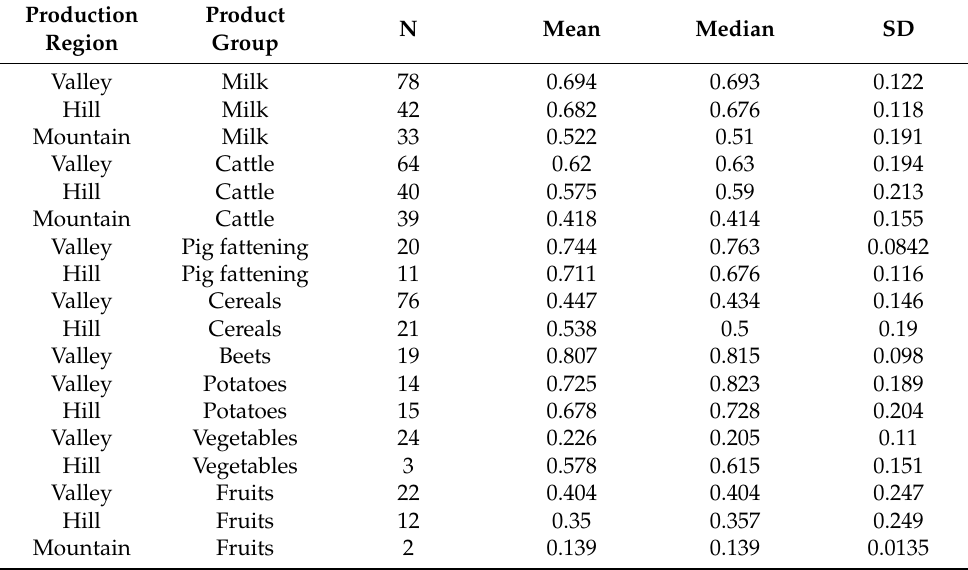
Table A7. Summary environmental efficiency scores grouped by production-region.